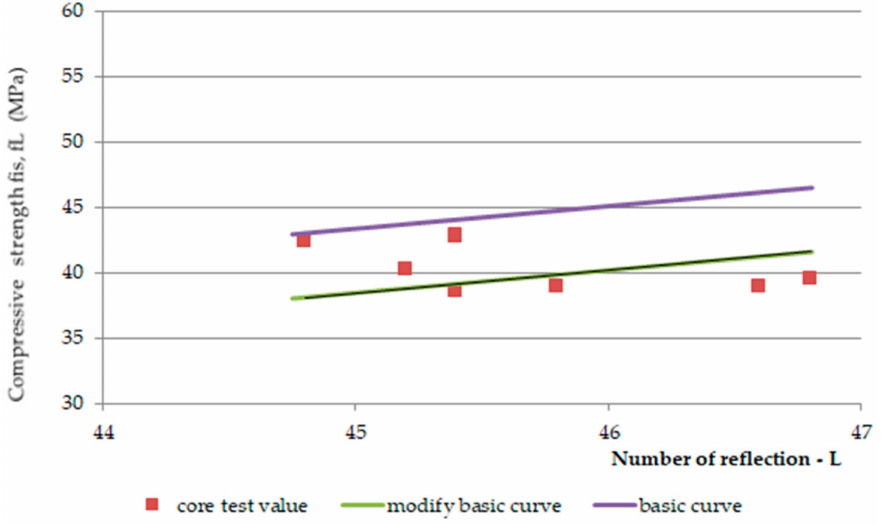
Figure 14. Test results according to the indirect method taking into account the results of destructive and non-destructive tests. Table 8. Compressive strength obtained from destructive and non-destructive